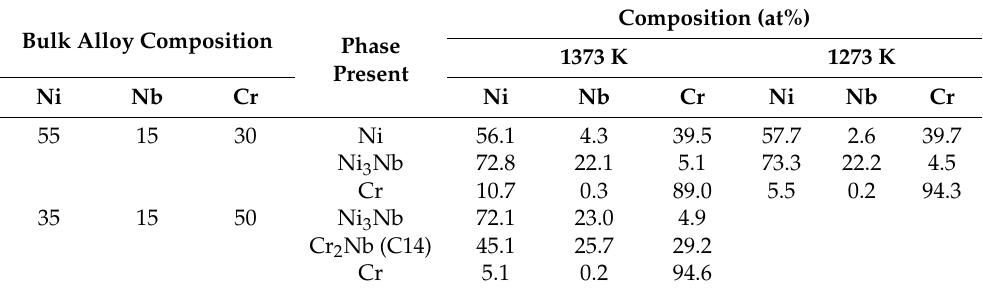
Table 1. Analyzed compositions of the Ni, Cr and Ni 3 Nb phases in the Ni–Nb–Cr ternary system at 1373 and 1273 K.